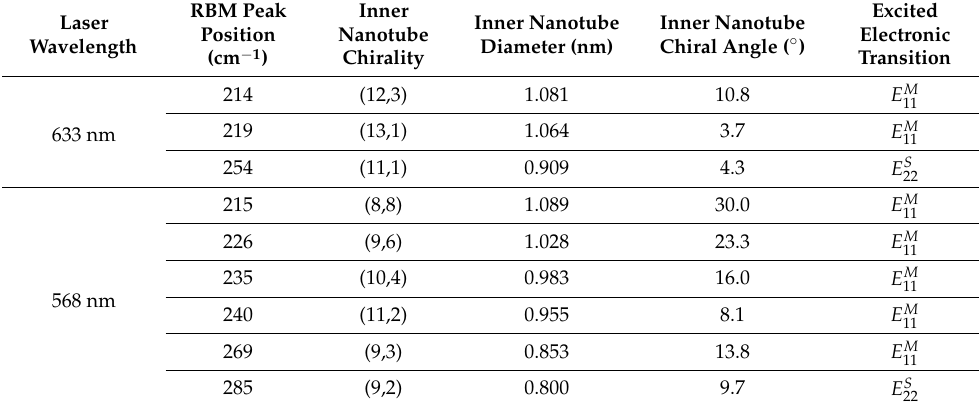
Figure 4. ( a ) The fitting of the RBM-band of the Raman spectrum of the NiCp 2 -filled SWCNTs annealed at 540 ◦ C for 514 min, acquired at a laser wavelength of 633 nm (E ex = 1.96 eV), with the components of individual outer and inner tubes. The spectrum with the fitted background (A) and the same spectrum with the subtracted background fitted with individual components (B). ( b ) The enlarged view of the fitting of the inner tube peaks. The most intense inner tube peaks are labeled. Table 1. The positions of peaks of inner tubes in the RBM-band of Raman spectra of the NiCp 2 - and CoCp 2 -filled annealed samples acquired at laser wavelengths of 633 nm (E ex = 1.96 eV) and 568 nm (E ex = 2.18 eV) as well as chiralities, diameters, chiral angles and excited electronic transitions of inner tubes that were assigned to these